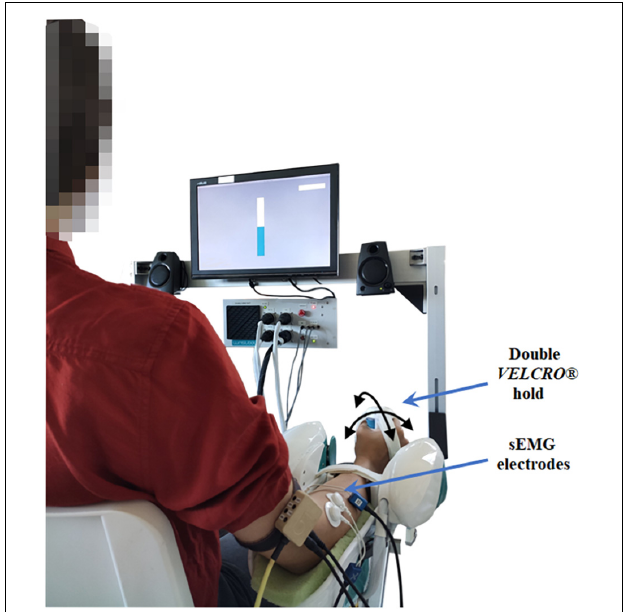
FIGURE 1 | A schematic representation of the participant, bipolar electrodes placement and robot position in the experimental setup. An example of the visual feedback of the grip force is shown through a virtual bar on the screen in front of the